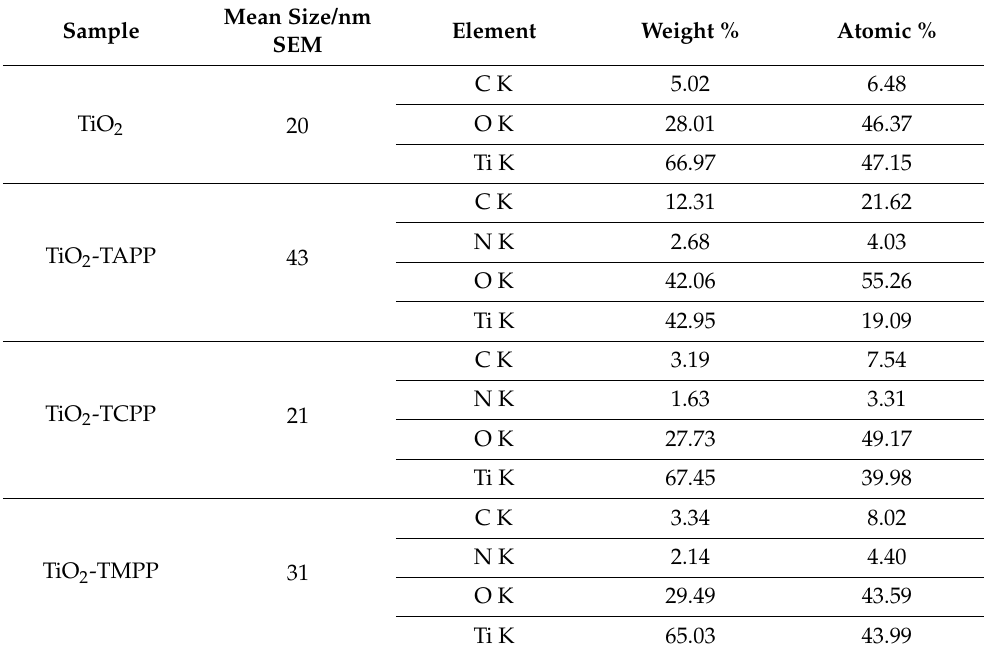
Table 1. Dimension of the particles and EDS analysis of the TiO 2 and TiO 2 -porphyrins samples.